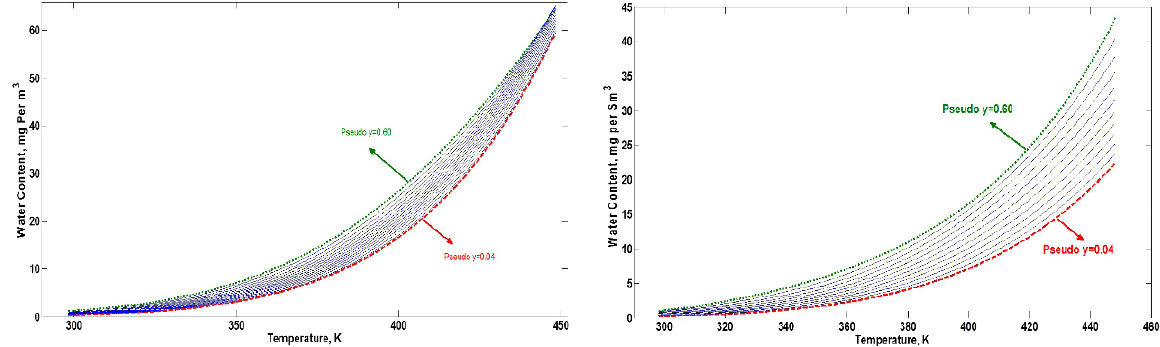
Figure 3. Prediction of water content of sour natural gases and acid gas mixtures at 14000 kPa (abs).